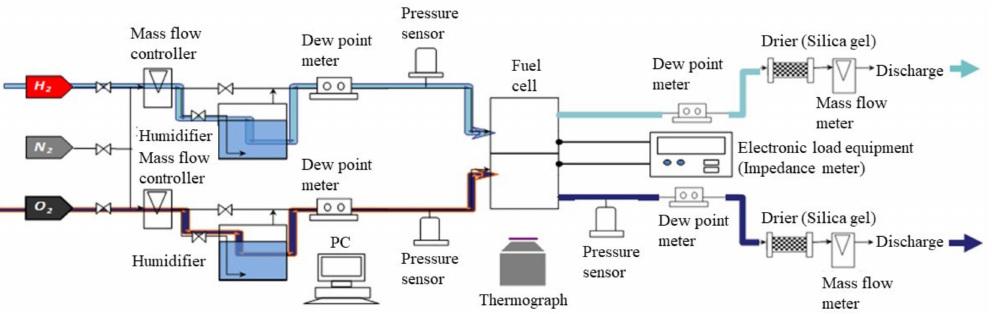
Figure 4. Schematic drawing of the experimental setup for the power-generation experiment, to measure the temperature distribution by a